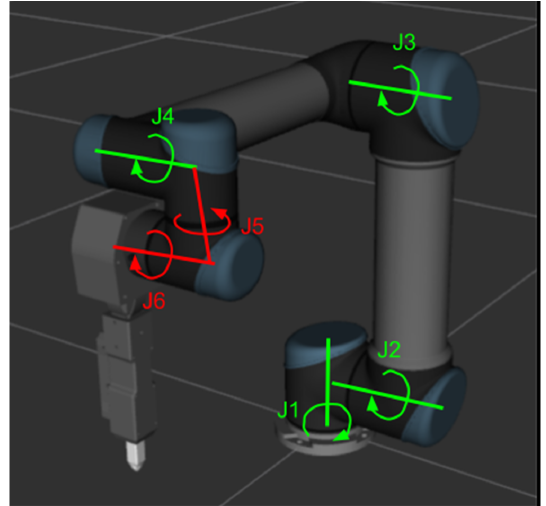
Figure 14. Articulated model of the adapted UR5. The green joints (J1, J2, J3, and J4) correspond to the articulated joints. The red (J5 and J6) correspond to the fixed joint of the kinematic model.